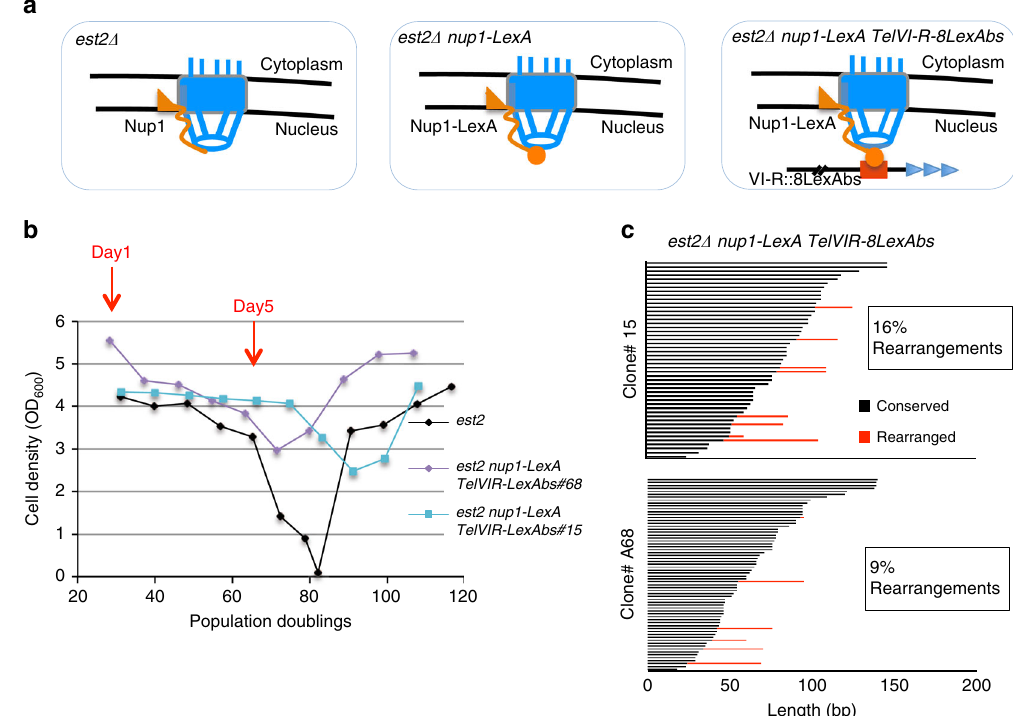
Fig. 6 Tethering of TelVI-R to Nup1-LexA prevents SCR. a Schematic of the three est2 Δ strains expressing (right panels) or not (left panel) nup1-LexA and bearing either wild-type TelVI-R or modi fi ed TELVI-R with eight LexA DNA-binding sites inserted 1.2 kb away from the TG 1 – 3 repeats 35 . b Senescence pro fi les of the two est2 Δ nup1-LexA TelVI-R-8lexAbs clones (#15 and #A68) used for sequencing. The est2 Δ pro fi le is from Supplementary Fig. 4 and is shown for comparison. D1 and D5 are highlighted in red. c TelVI-R sequence analysis of the clones est2 Δ nup1-LexA TelVI-R-8LexAbs #15 and #A68 at Day 5 (see Supplementary Fig. 5 for the statistics of comparison with WT TelVI-R